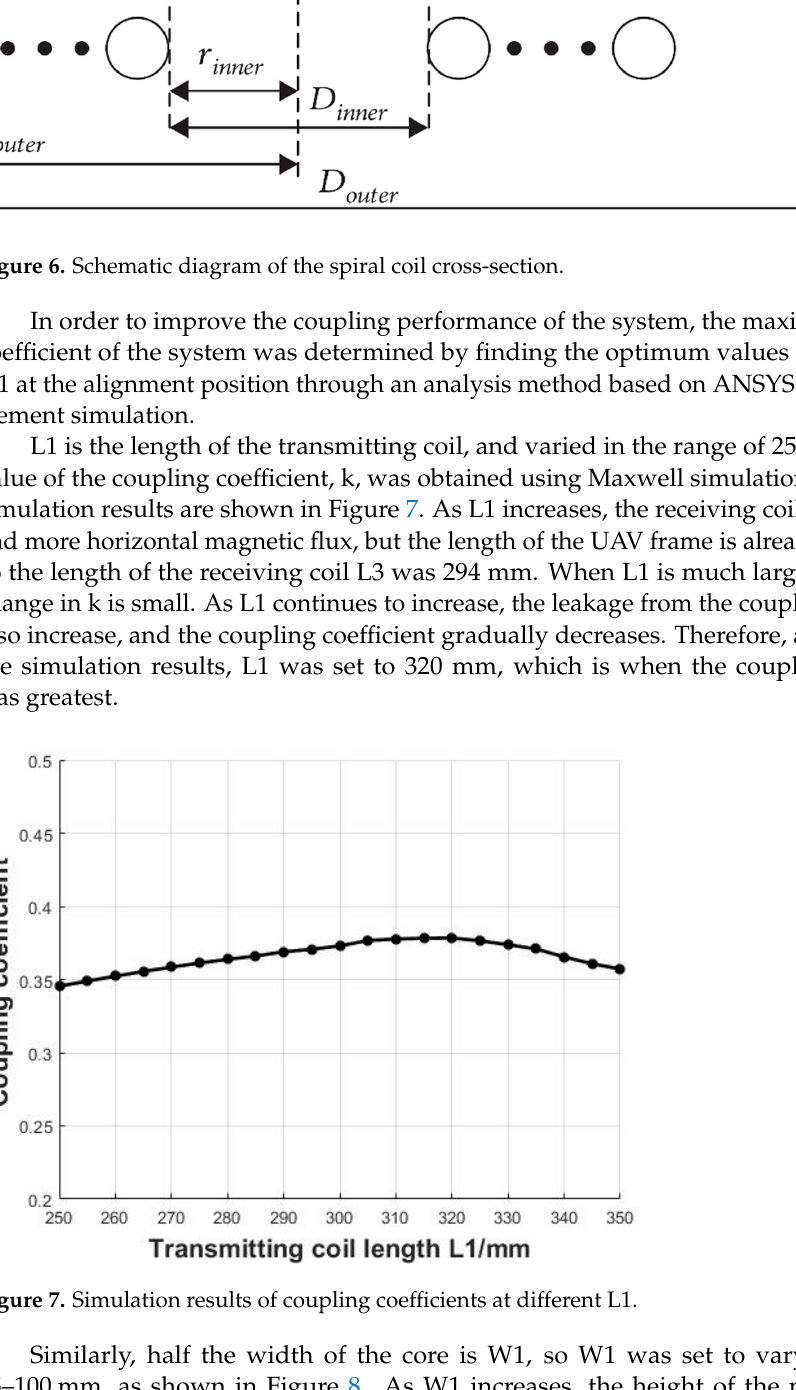
Figure 6. Schematic diagram of the spiral coil cross-section.